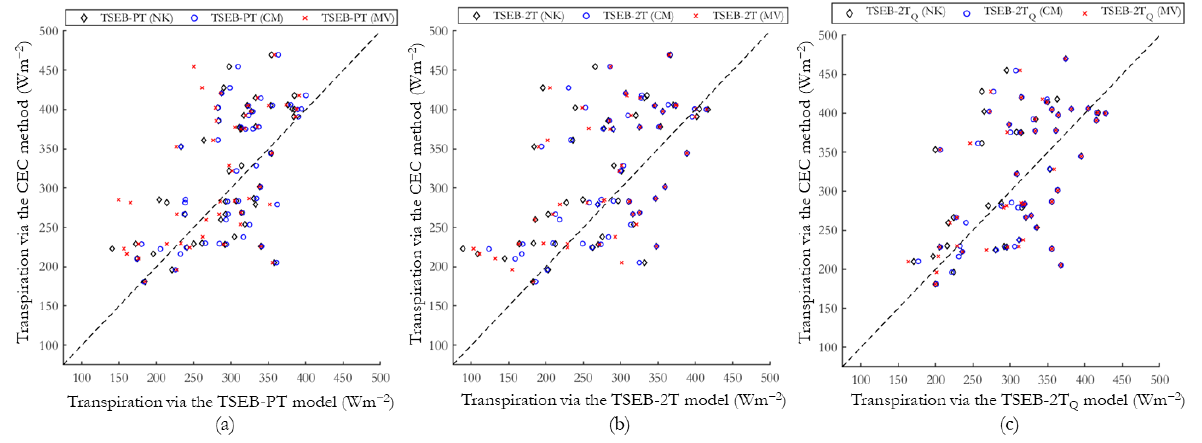
Figure 8. The comparison between the transpiration based on the CEC method and the transpiration modeled via the TSEB models (different TSEB models with different resistance models).